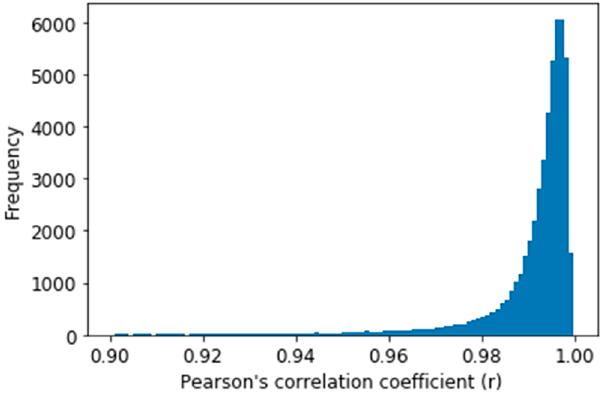
Figure 10. Distribution of Pearson’s correlation coefficient on the test dataset.